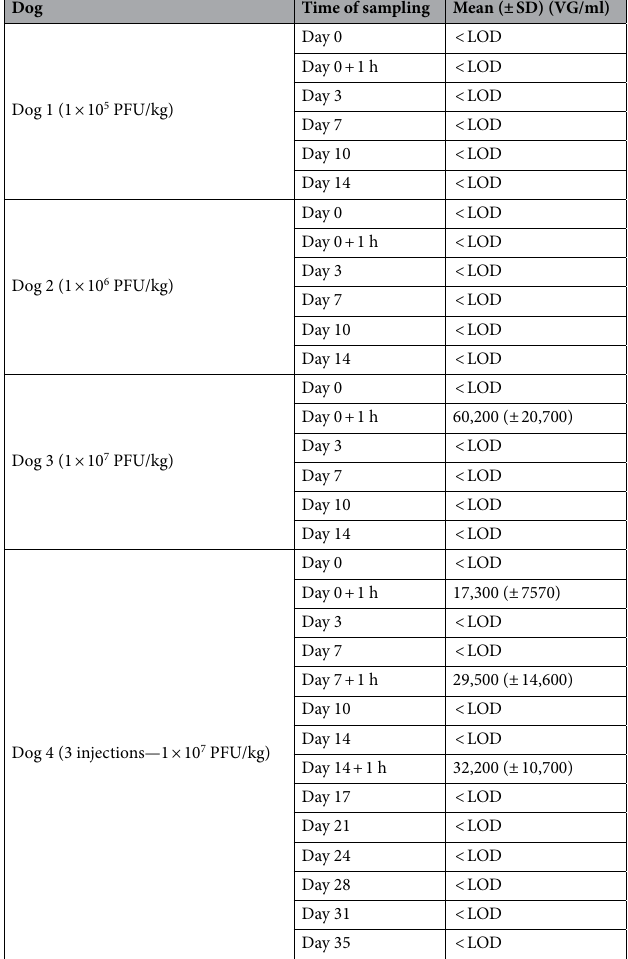
Table 2. Detection of vaccinia virus DNA in blood by q-PCR assay after single and multiple intravenous injection of TG6002. All samples were measured in triplicate. LOD limit of detection, SD standard deviation, VG viral